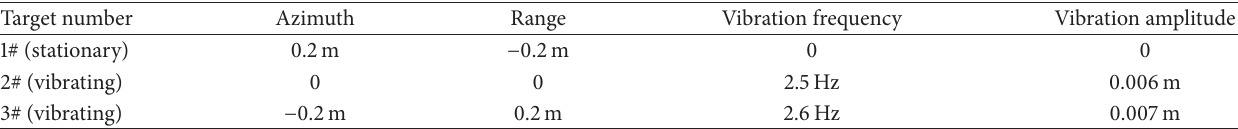
Table 2: Point target